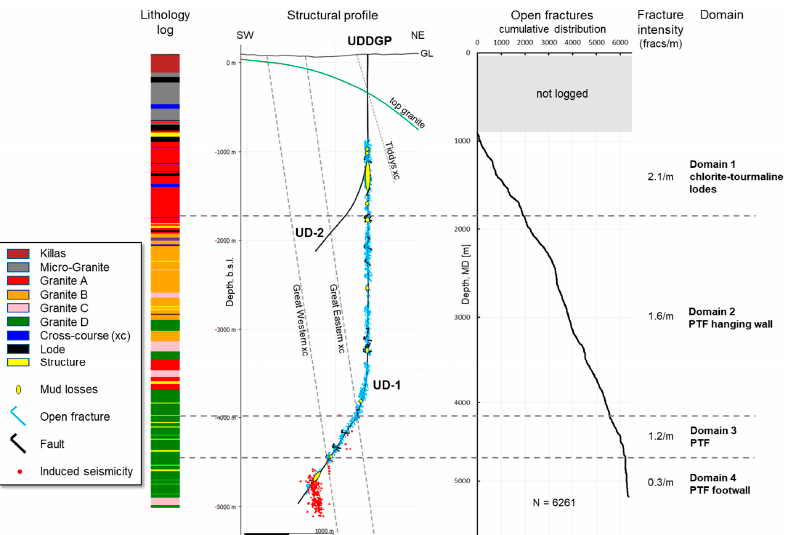
Figure 3. Fracture distribution interpreted from ultrasonic logs in UD − 1. Note that the depth scale of the structural profile is the true vertical depth below sea level. Cumulative fracture distribution and lithology log originally in measured depth below ground level are shifted and stretched to fit the true vertical depth scale [11]. Two large-scale fractures were detected by induced seismic events during drilling and subsequent injection testing.